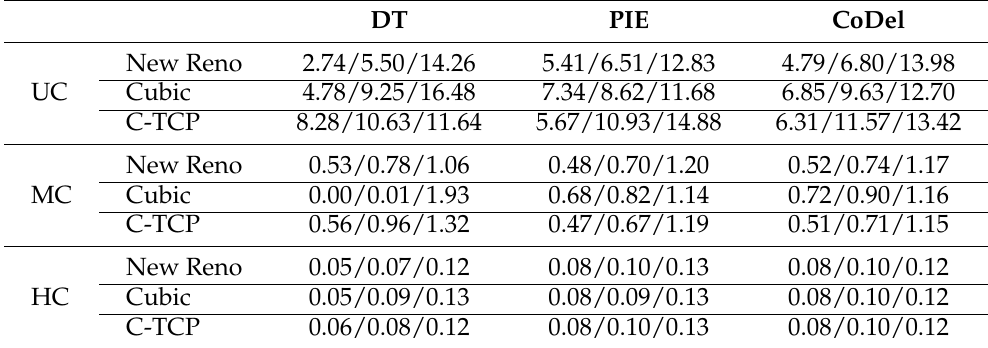
Table 6. Quartiles of flows’ throughput [Mbps] in the Access Link scenario with common TCPs, UC—uncongested, MC—mildly congested, HC—heavily congested network.